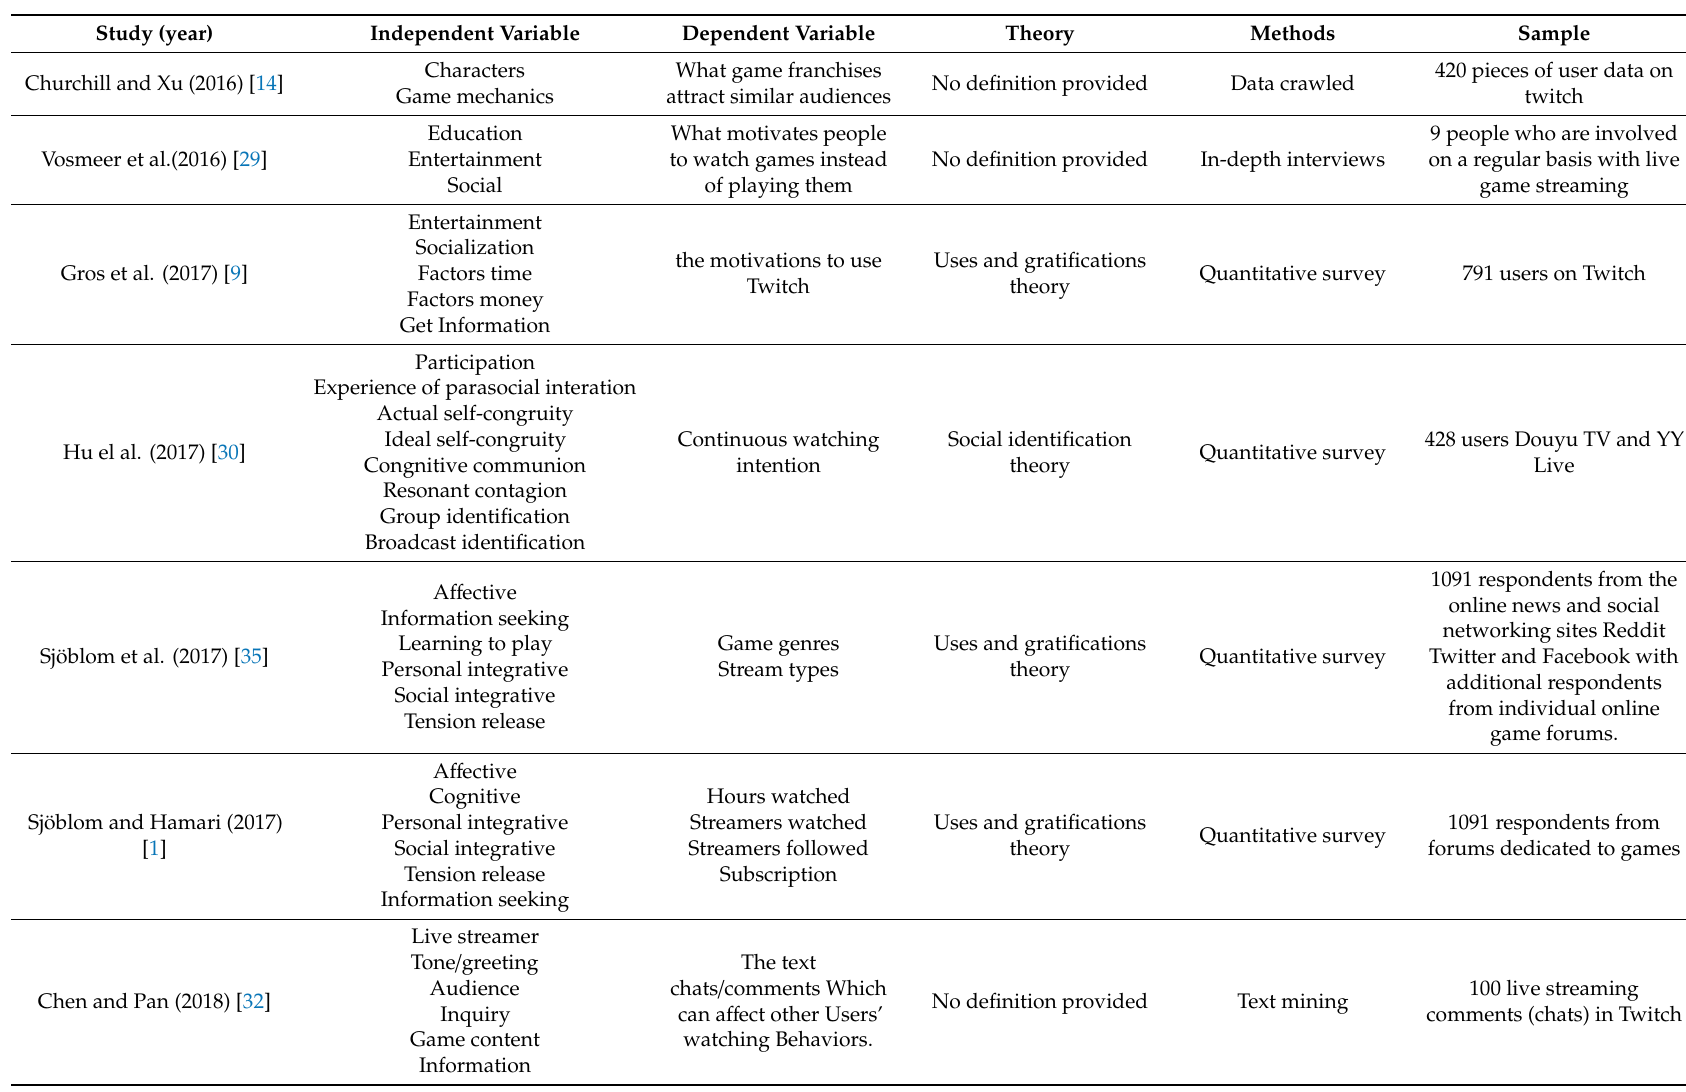
Table A2. Summary of studies included in the audience